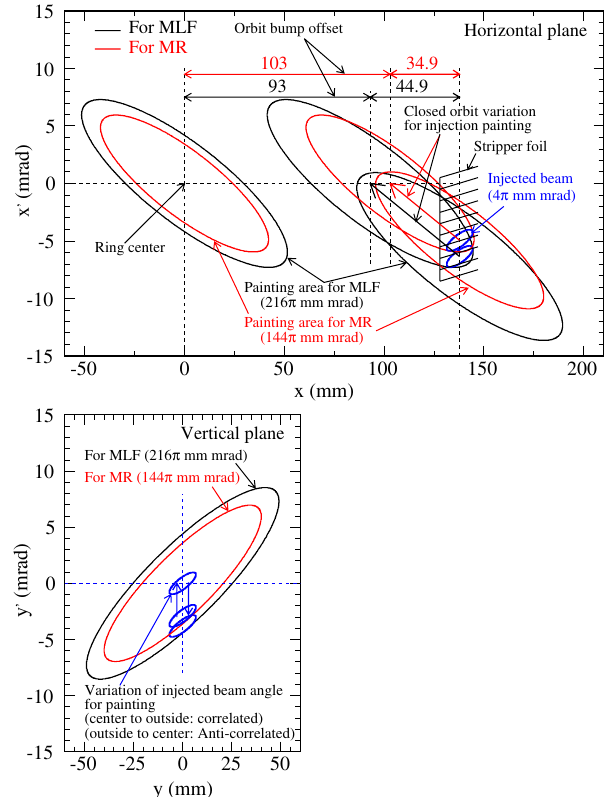
FIG. 5. Schematic view of the transverse injection painting process in the RCS for horizontal and vertical planes as shown in the top and bottom figures, respectively. A closed orbit variation is done in the horizontal plane, while the injected beam angle itself is changed in the vertical direction. The design painting emittance for the MLF and MR are 216 and 144 (cid:1) mm mrad , respectively. As the stripper foil position is fixed, the only choice for switching a smaller painting area for the MR has to be done by changing an angle of the injected beam. The power supplies of the ISEP1-2 are dc and thus PSTR magnets are additionally installed for that purpose. The PBV1-2 located in the injection BT line are used for directly changing vertical angle of the injected beam to the change vertical paining area pulse to